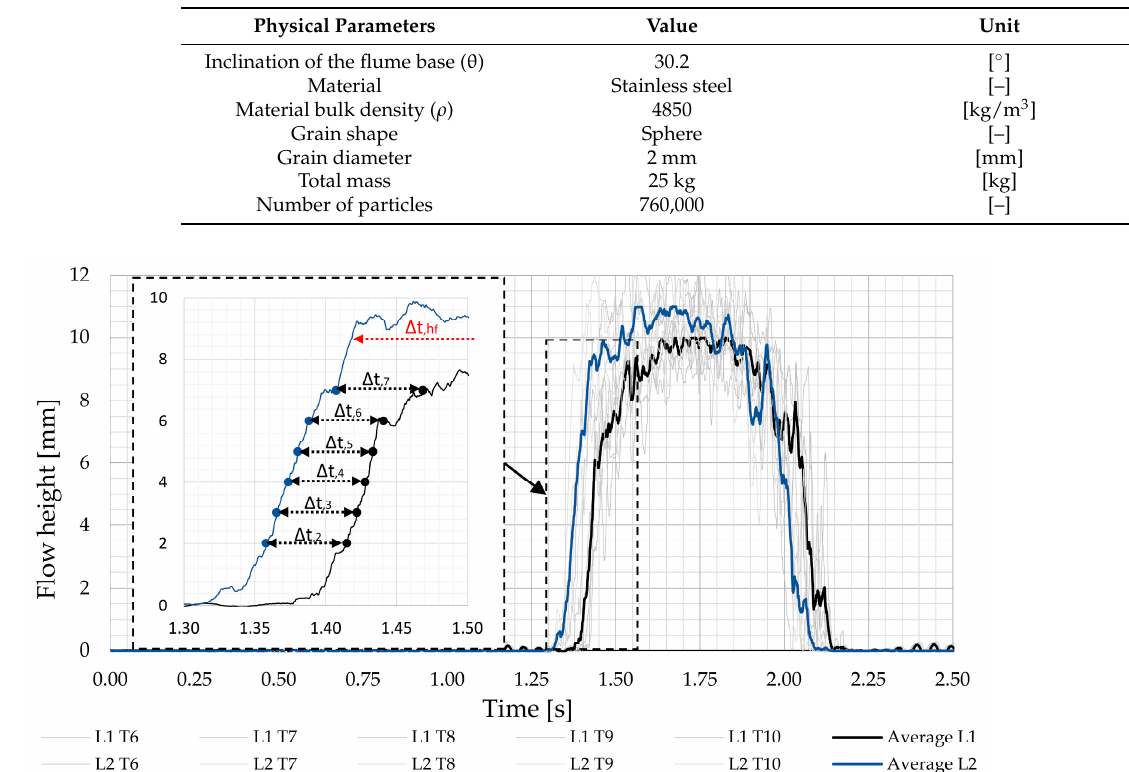
Figure 3. Force–time plot on the rigid barrier for the test series according to Table 2 with the mean values of the measured flow velocity ( v ) and flow height ( h f ) and the upper and lower measured values of the dynamic and static impact force ( F peak,mes , F stat,mes ). Table 2. Parameters of the test boundary conditions of the measurement results shown in Figure 3.